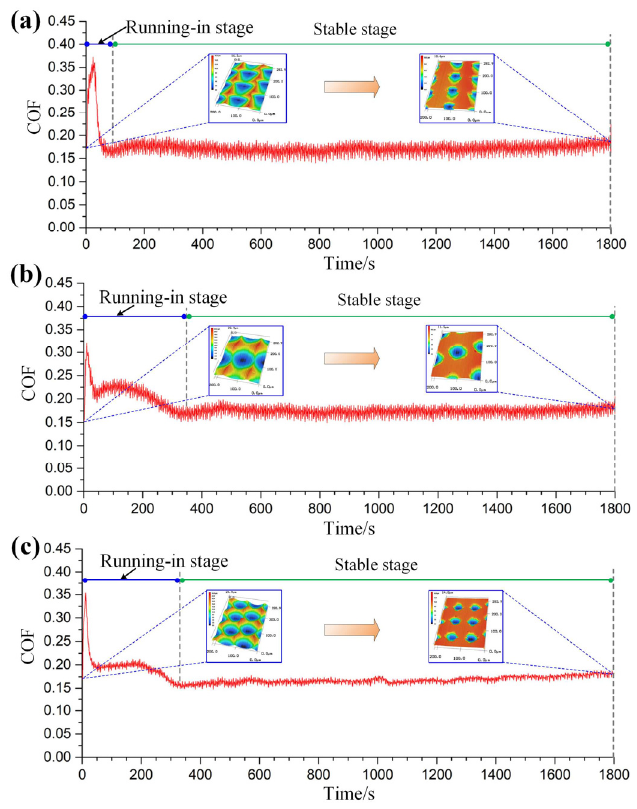
Figure 12. Variation curves of COF corresponding to the other three micro-textured surfaces: ( a ) surface #2; ( b ) surface #3; ( c ) surface #4.